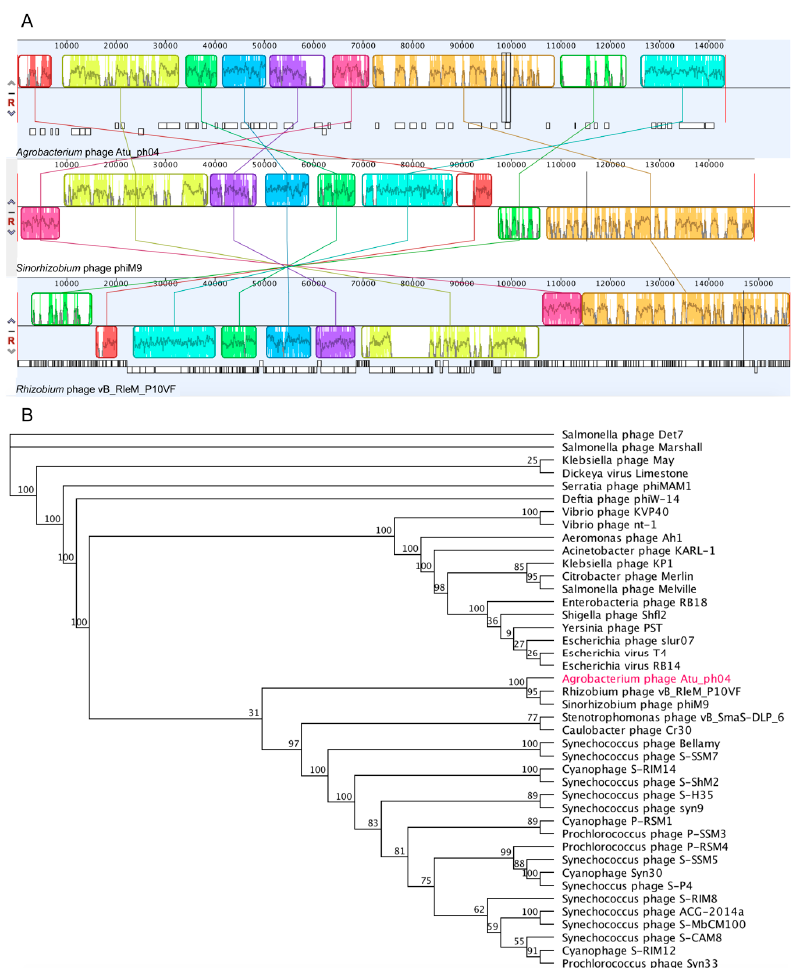
Figure 3. Phylogenetic analysis of Atu_ph04 with its relatives. ( A ) Mauve genome alignment of Atu_ph04, Sinorhizobium phage phiM9, and Rhizobium phage RleM_P10VF. ( B ) Phylogenetic tree of portal vertex protein.